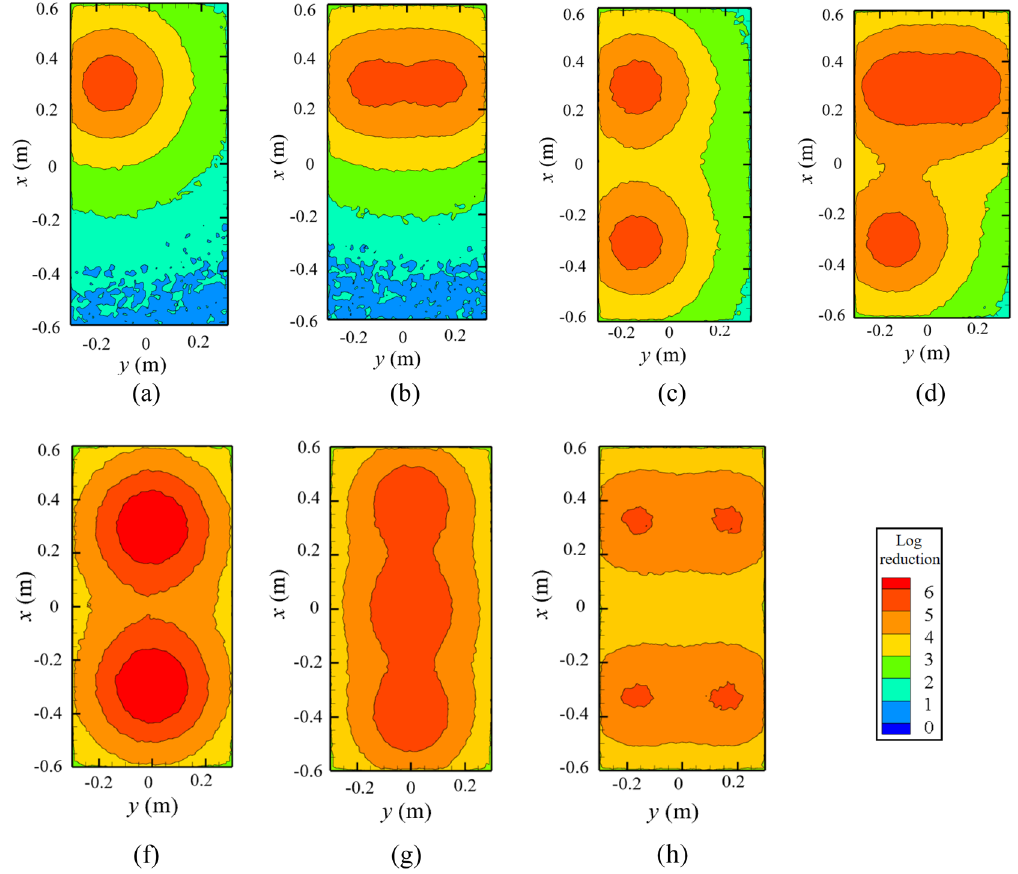
Figure 6. Numerically modeled inactivation efficiency distribution for different dining situations: ( a ) one lamp for a single diner; ( b ) two lamps for two diners sitting face to face; ( c ) two lamps for two diners sitting on the same side; ( d ) three lamps for three diners; ( f ) two lamps for four diners; ( g ) three lamps for four diners; and ( h ) four lamps for four diners.